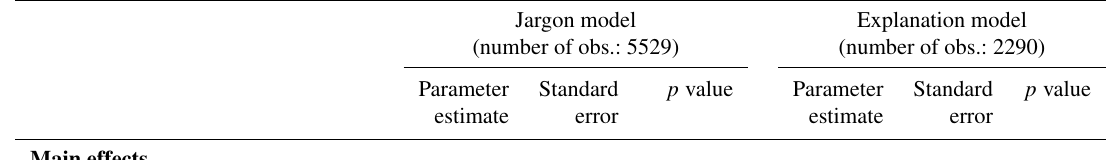
Table B3. Parameter estimates of the jargon and explanation models examining participants’ ease of understanding of the TTA statements. Bolded and italicized levels are used for calculating the estimated marginal probabilities for the post hoc